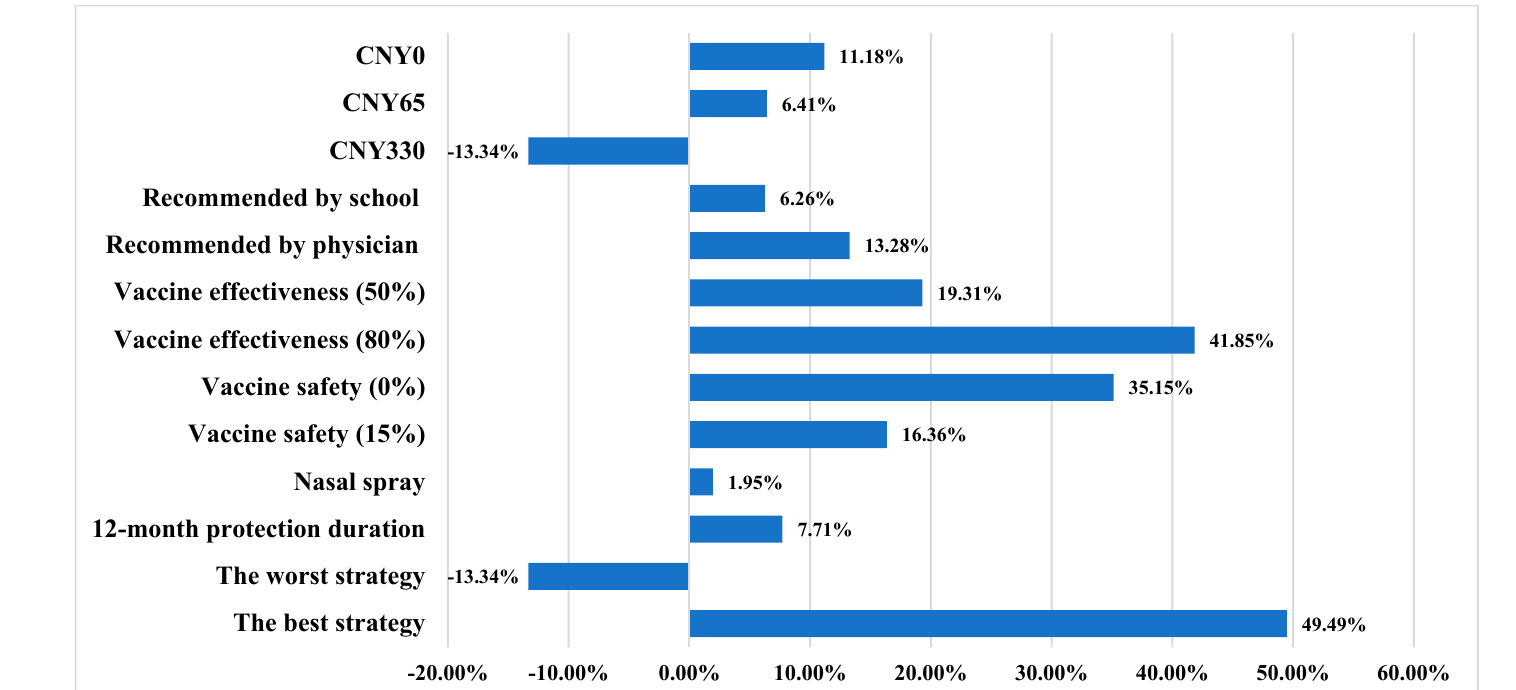
Figure 2. One-way variations in probability of vaccine uptake. CNY: Chinese Yuan.